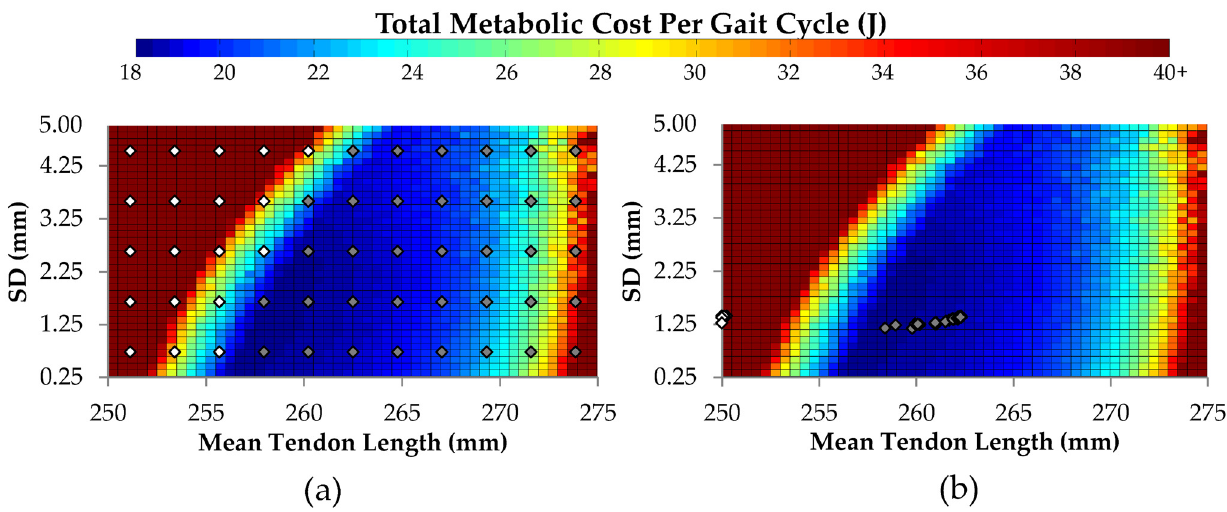
Fig 12. Tendon remodeling exploration. a) 55 equally spaced initial tendon geometries selected across the metabolic cost region, b) final geometries after 720 days of remodeling. White points indicate unstable initial geometries, dark points indicate initial geometries converging to an equilibrium